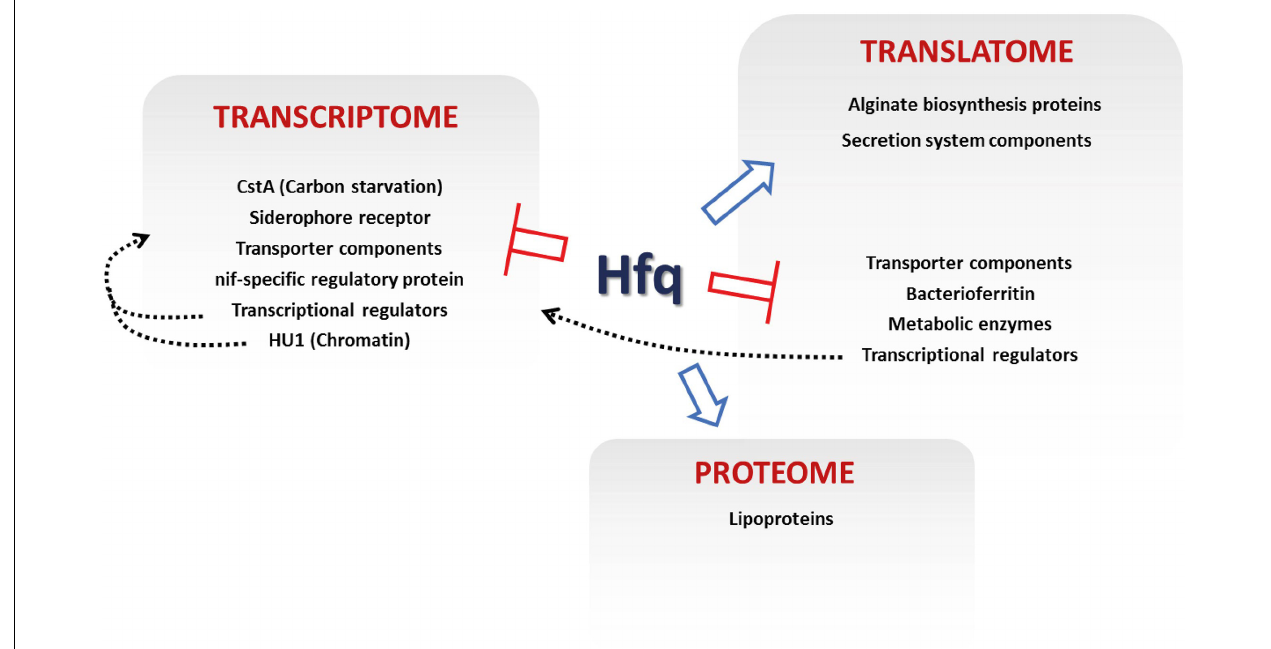
FIGURE 5 | Regulatory effects of Hfq in P. fluorescens . The key loci controlled by different levels of Hfq regulation are indicated. Blue arrows show positive Hfq control, red bars denote negative control. Dashed gray arrows show proposed indirect regulations by transcriptional regulation and chromatin